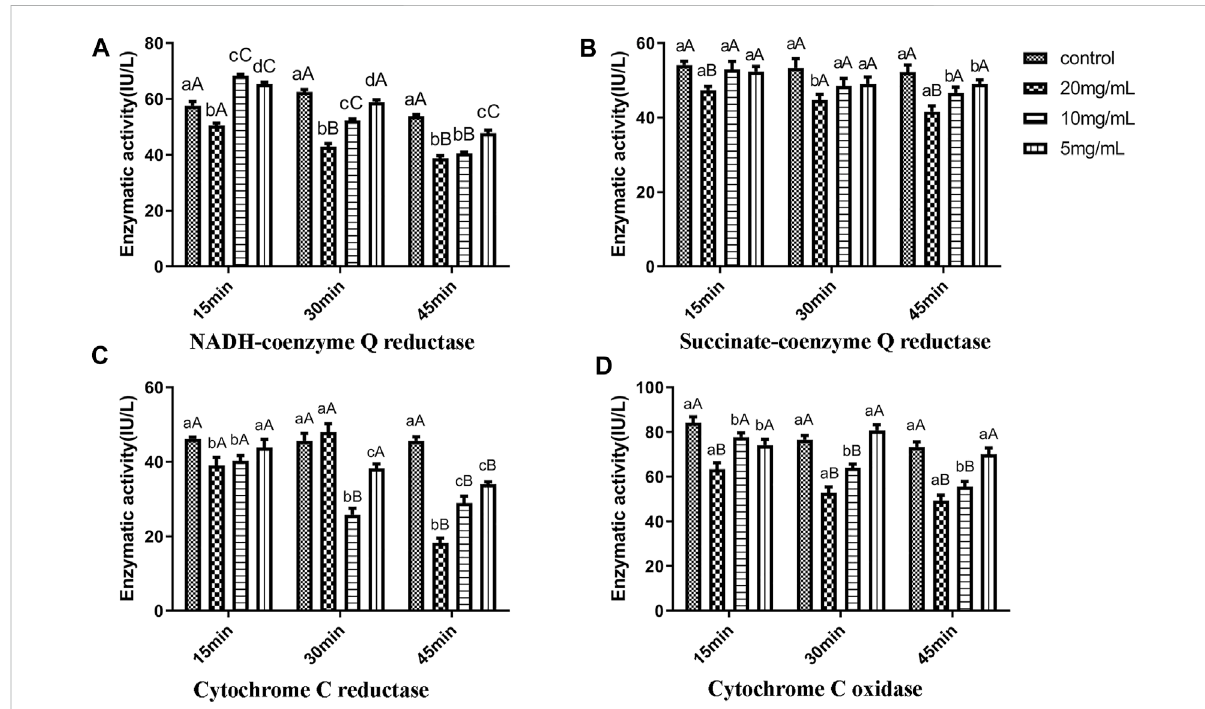
FIGURE 5 Thechangesofenzymeactivityofscabiesmitestreatedfor15,30,and45 min. (A) MitochondrialComplexIactivity; (B) MitochondrialComplex II activity; (C) Mitochondrial Complex III activity; (D) Mitochondrial Complex IV activity. The difference between data with the different small letters within a column is signi fi cant ( p < 0.05), and the difference between data with the different capital letters is at the ( p < 0.01)